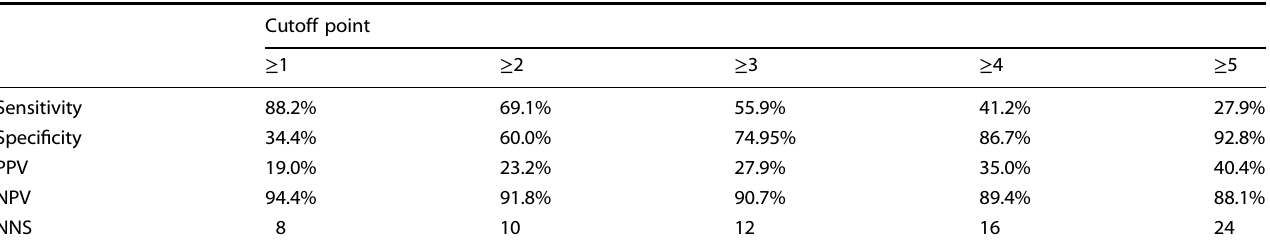
Table 3. Sensitivity, speci fi city, PPV, NPV, NNS of the SCSQ to predict PBD FEV1/FVC < LLN at different cutoff points as observed in the BOLD test sub- sample